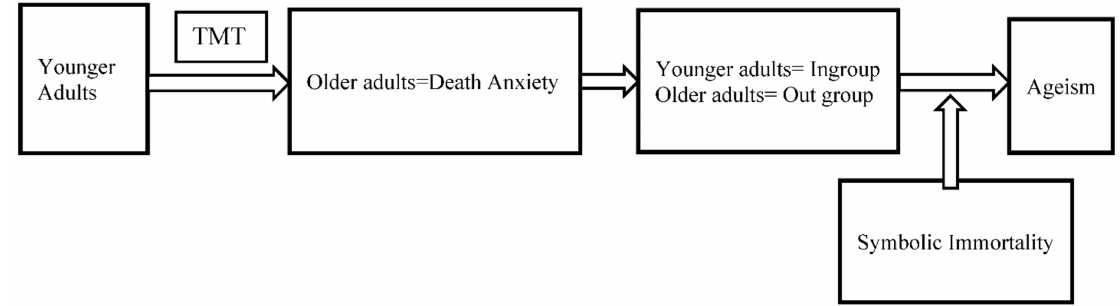
Figure 1. The etiological model for ageism among younger